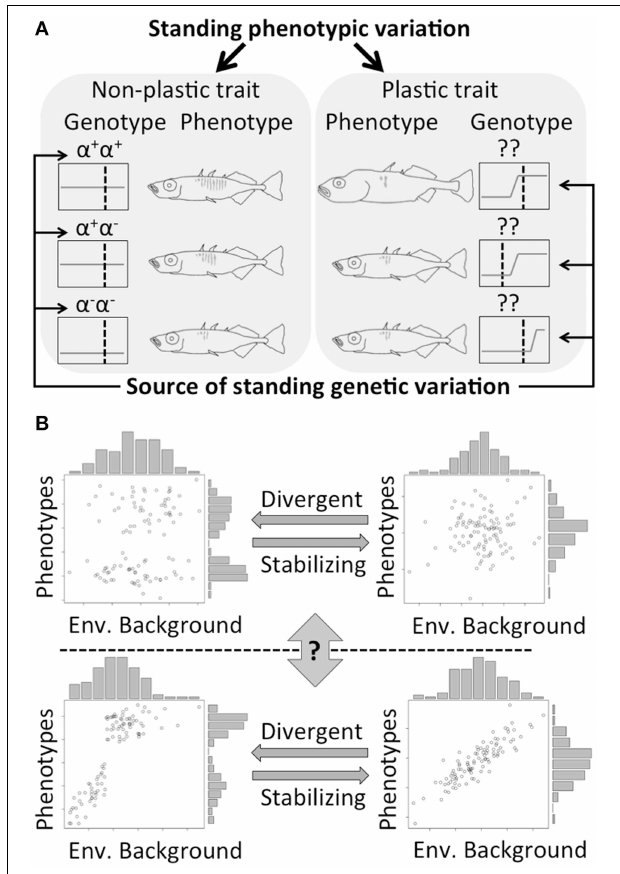
FIGURE 1 | (A) Different types of standing phenotypic variation. Different alleles result in phenotypic difference between individuals for non-plastic traits. Phenotypic difference in plastic trait can result from both environmental variation and changes in the reaction norm. ( α and ?: different loci responsible for the focal trait; + and − : the existence and absence of a functional allele for that locus; gray lines in black boxes: the norms of reaction; dash lines: environmental conditions). (B) Transitions between different types of traits (from upper left to lower right: a discrete non-plastic trait, a continuous non-plastic trait, a discrete plastic trait, and a continuous plastic trait). The transition between continuous and discrete phenotypes can result from divergent-stabilizing selections. However, the question of “gene first or environment first?” on morphological evolution is still under intensive